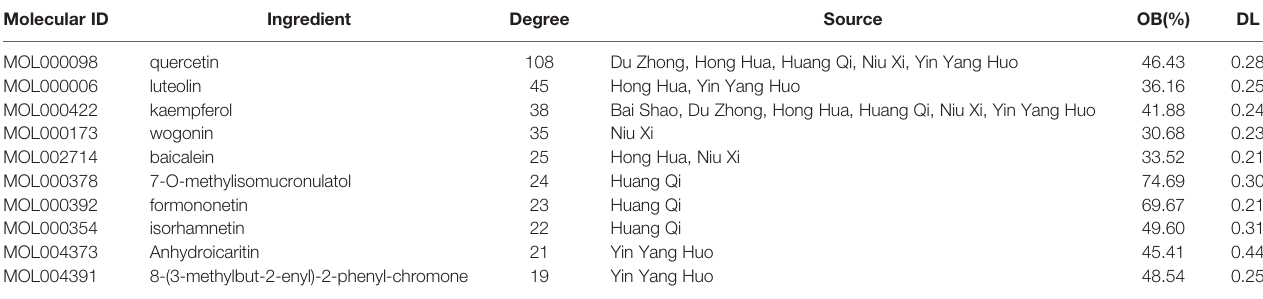
TABLE 2 | The top 10 key compounds of ZGBSF against OP.